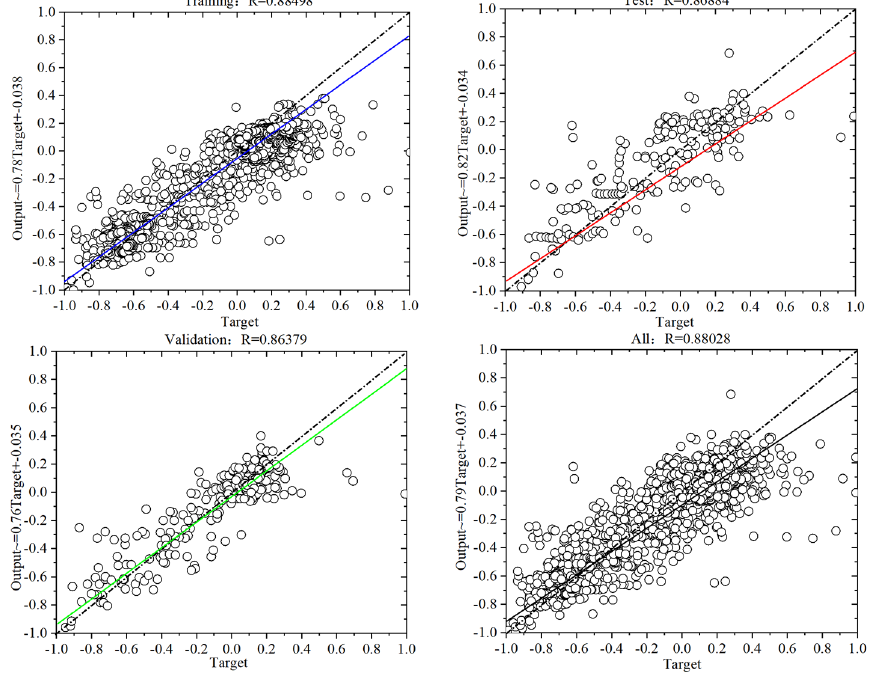
Figure 6. Correlation of BP modeling.